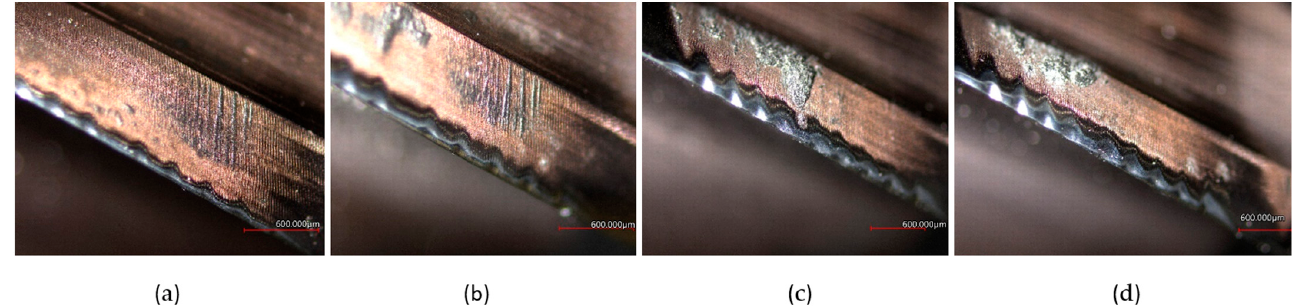
Figure 27. Tool wear, laminate thickness 3 mm.